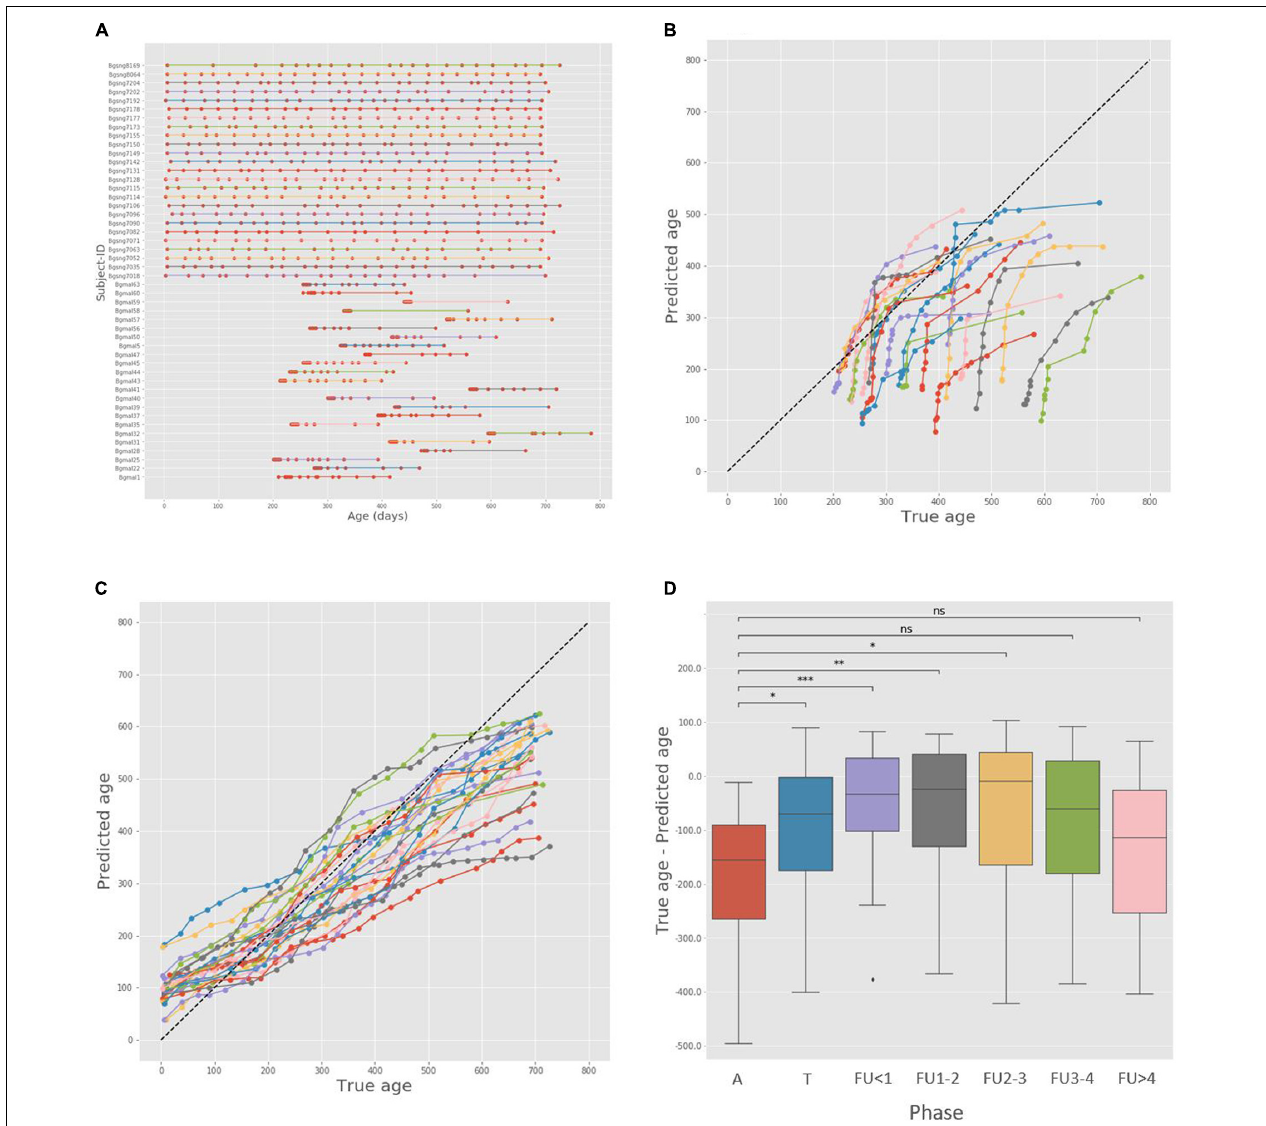
FIGURE 4 | Alignment-based age analysis and maturity indices in the Bangladesh cohort. (A) Ages of the malnourished and healthy children participating in the analysis. Subject-IDs of healthy children start with the prefix Bgsng (Bangladeshi singleton, found in the top half of the figure), and Subject-IDs of malnourished children start with the prefix Bgmal, found in the bottom half of the figure. (B) True and predicted age for all severe acute malnutrition (SAM) trajectories. The points representing each subject are colored similarly and connected with a line. (C) True and predicted age for all healthy singleton trajectories. (D) Box plot of relative maturity indices, calculated as the difference between true age and predicted age, across the different phase groups. Since each subject has multiple samples from each phase, we only used the latest sample in each phase per subject. A – Acute phase; T – Treatment; FU < 1 – Follow-up, under 1 month; FU1-2 – Follow-up, 1 to 2 months; FU2-3 – Follow-up, 2 to 3 months; FU3-4 – Follow-up, 3 to 4 months; FU > 4 – Follow-up, over 4 months. ns: p > 0.05; ∗ p ≤ 0.05; ∗∗ p ≤ 0.01; ∗∗∗ p ≤ 0.001; ∗∗∗∗ p <